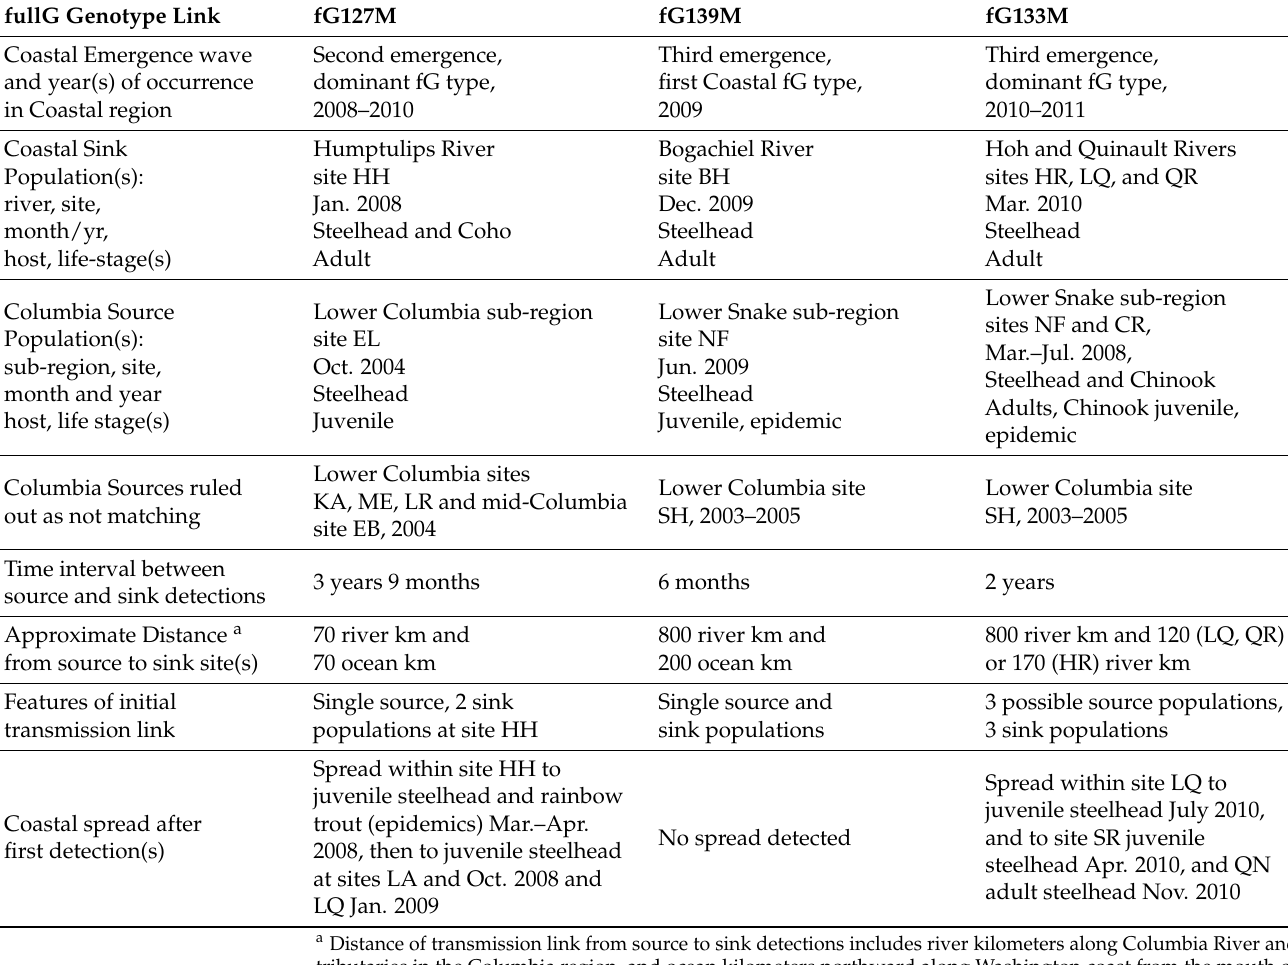
Table 6. Features of three transmission links identified from Columbia region sources to coastal steelhead sink